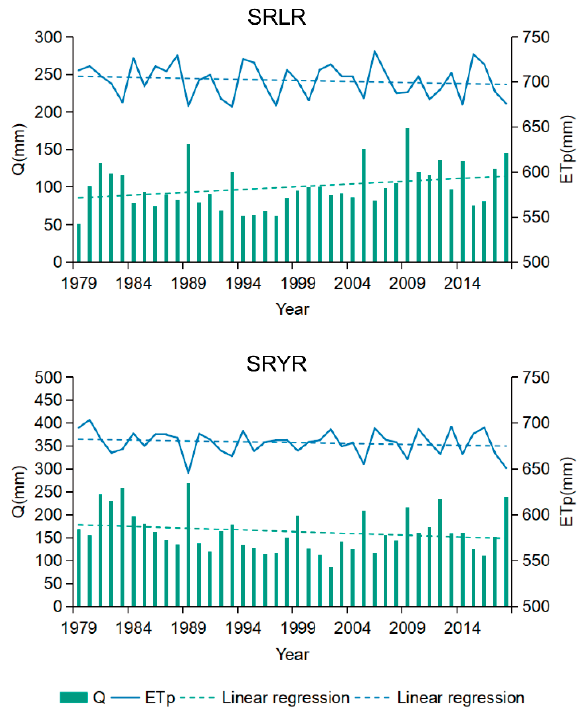
Figure 7. The changing trend of the Q and ET p from 1979–2018 in SRLR and SRYR.